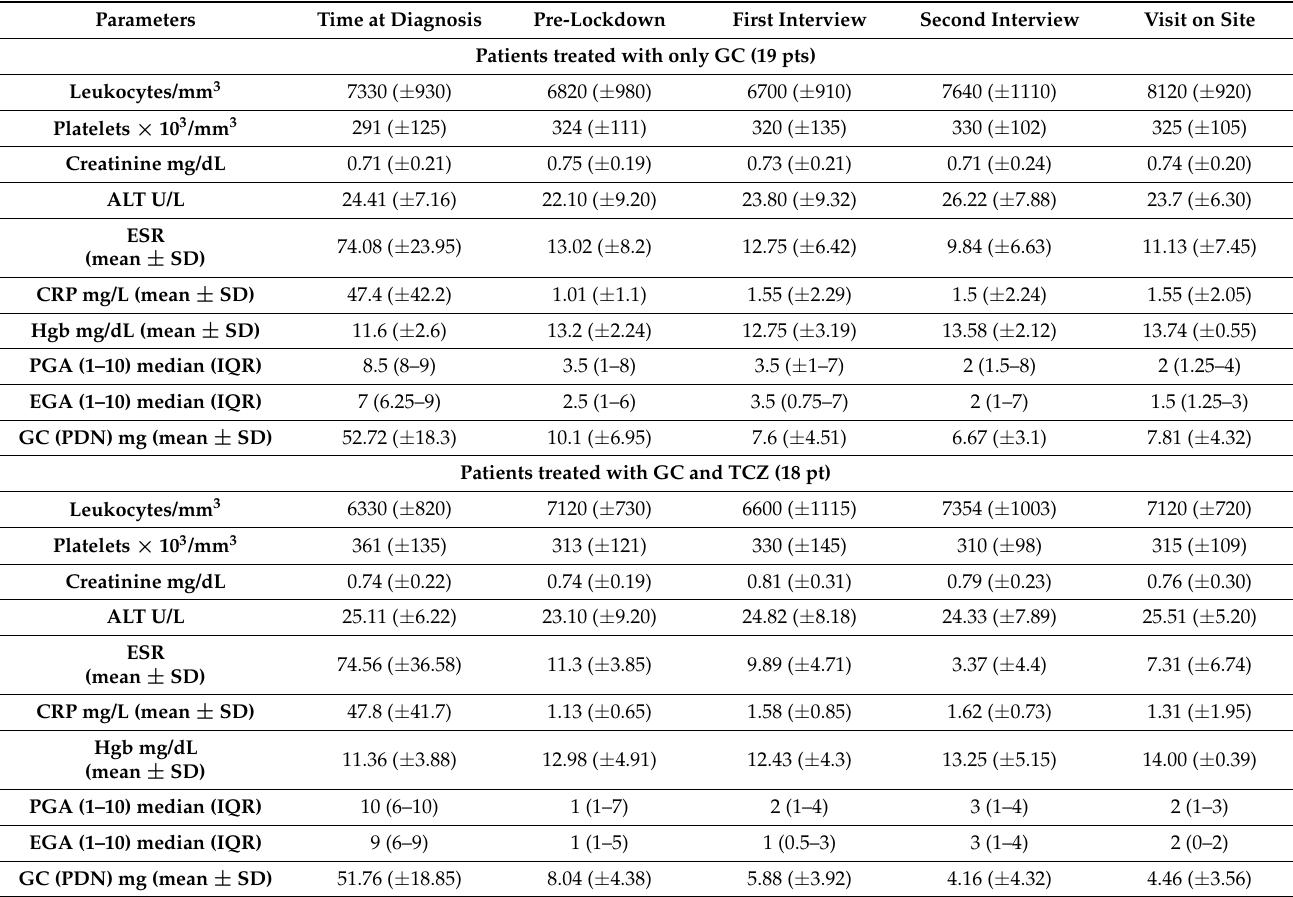
Table 2. Disease course and remote monitoring.